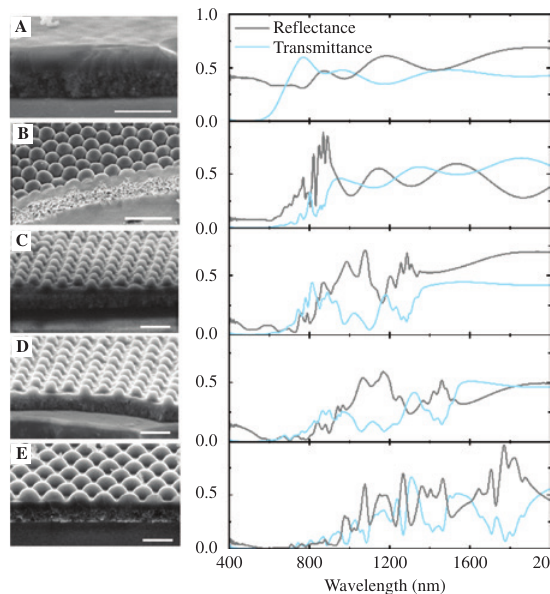
Figure 3: Optical response of all-dielectric metasurfaces with varying lattice